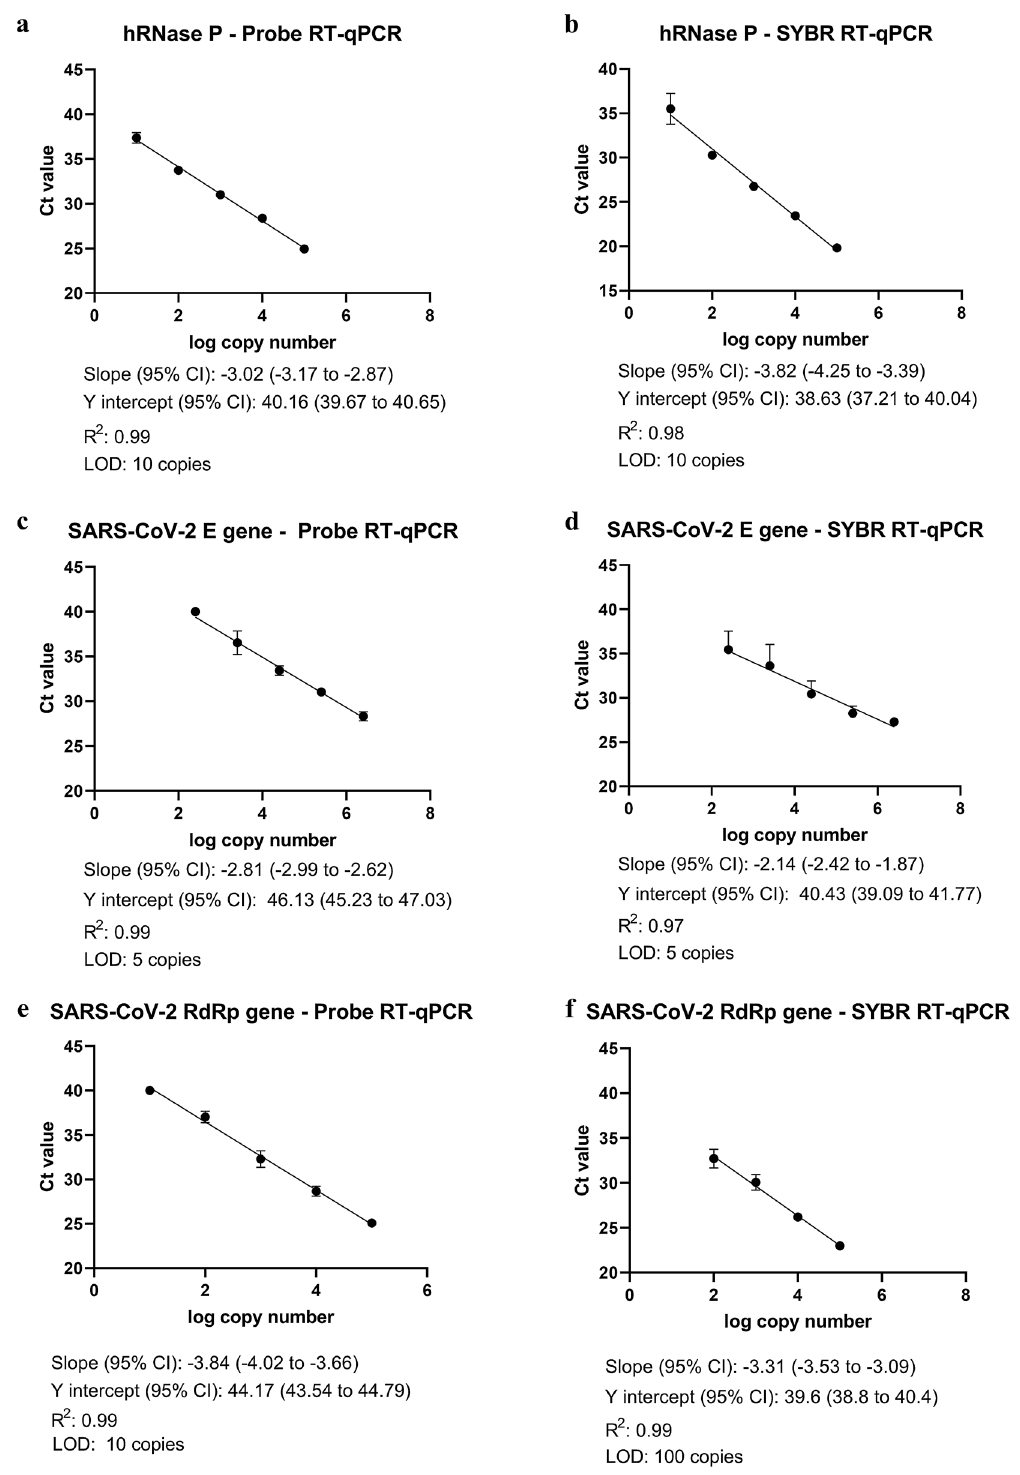
Figure 2. S tandard curves of the targeted genes generated with SYBR green-based and hydrolysis probed-based RT-qPCR